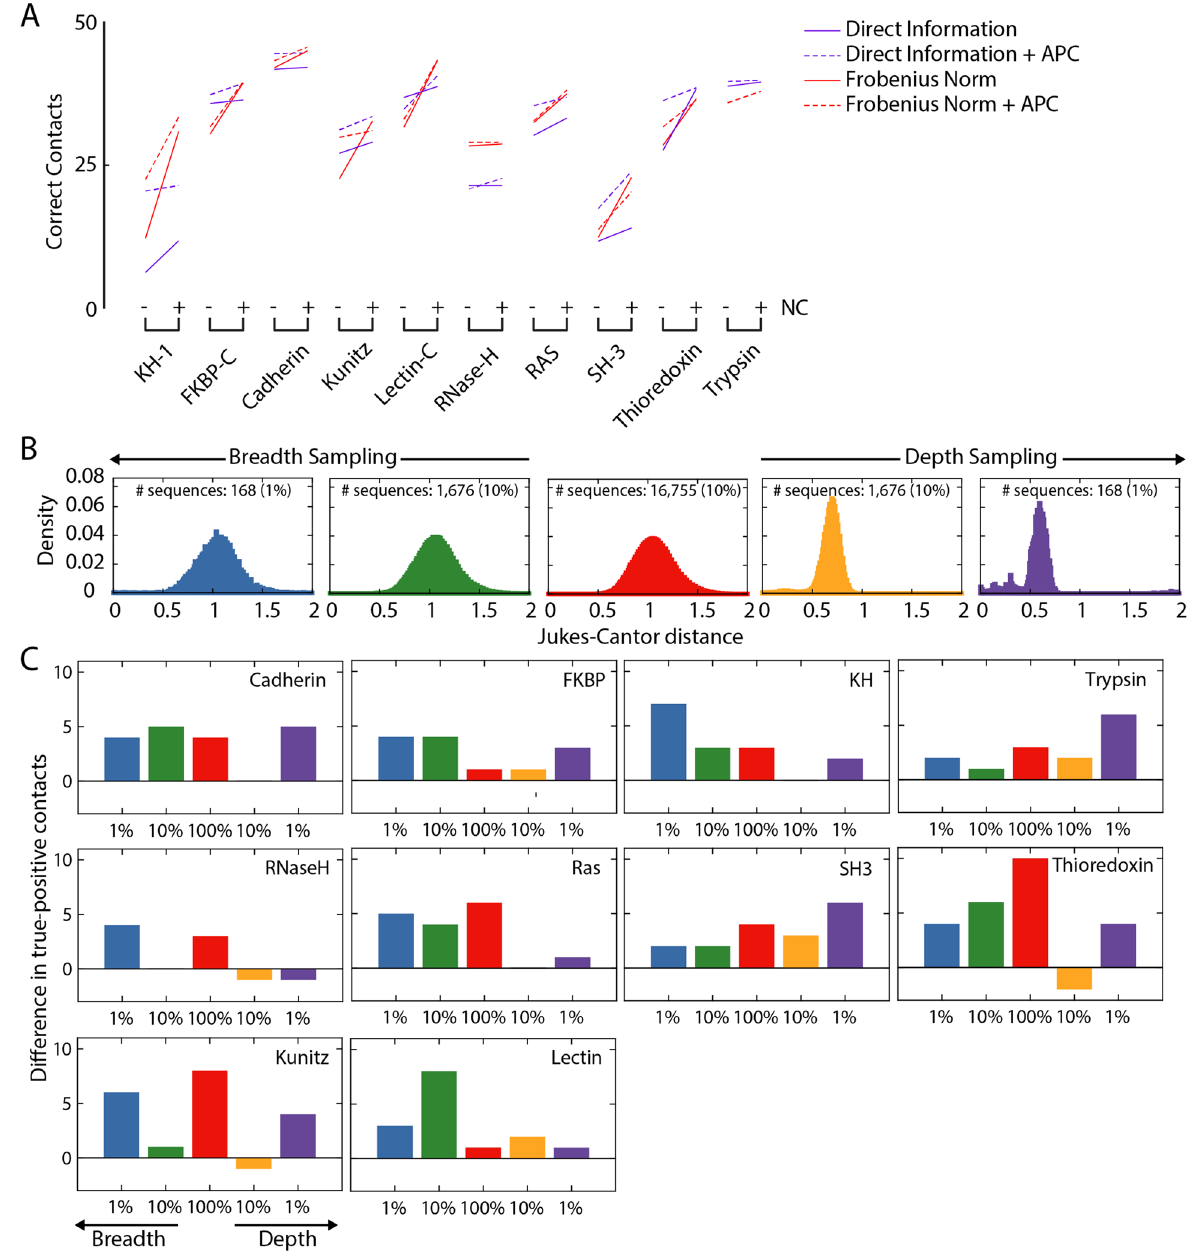
Figure 2. NC can improve predictions of structural contacts across proteins and coevolution methods, and resolve information loss due to subsampling of sequences. ( A ) NC increased the number of true-positive structural contacts among the first 50 predictions for 10 highly conserved proteins predicted by DCA using DI or Frobenius norm, without or with APC. We chose the maximum number of recovered true-positive structural contacts from NC applied across four phylogenetic cutoffs; the set of cutoffs was consistent across all proteins (0.2, 0.5, 0.8 and 1.1). ( B ) MSAs were subsampled across the breadth (random sampling) and depth (sorted sampling) of the MSA. Typically, the distribution of Jukes–Cantor distances in the MSA (red) remained essentially unchanged for breadth sampling (green and blue), while it shifted to lower values (as expected) for depth sampling (gold and purple); shown is the KH domain. ( C ) NC generally increased the number of true- positive structural contacts among the first 50 predictions relative to DCA employing DI (without APC) across proteins and both breadth and depth sampling (for DI with APC, see Fig. S3). Small decreases occurred for depth sampling of RNase H, thioredoxin, and